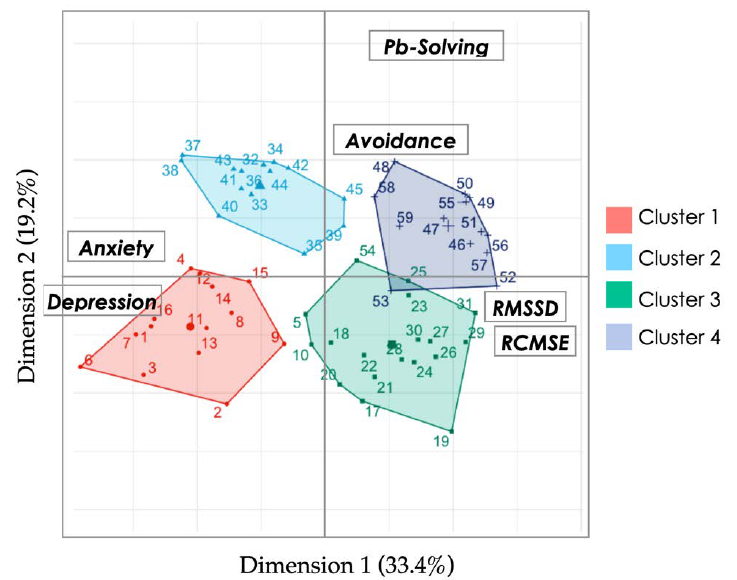
Figure 6. Mapping of the clusters as a function of PCAmix axes: Dim1 x -axis and Dim2 y -axis are defined from results illustrated in Figure 5. Individuals are numbered and colored according to their cluster. The barycenter of each cluster is represented by a larger symbol.